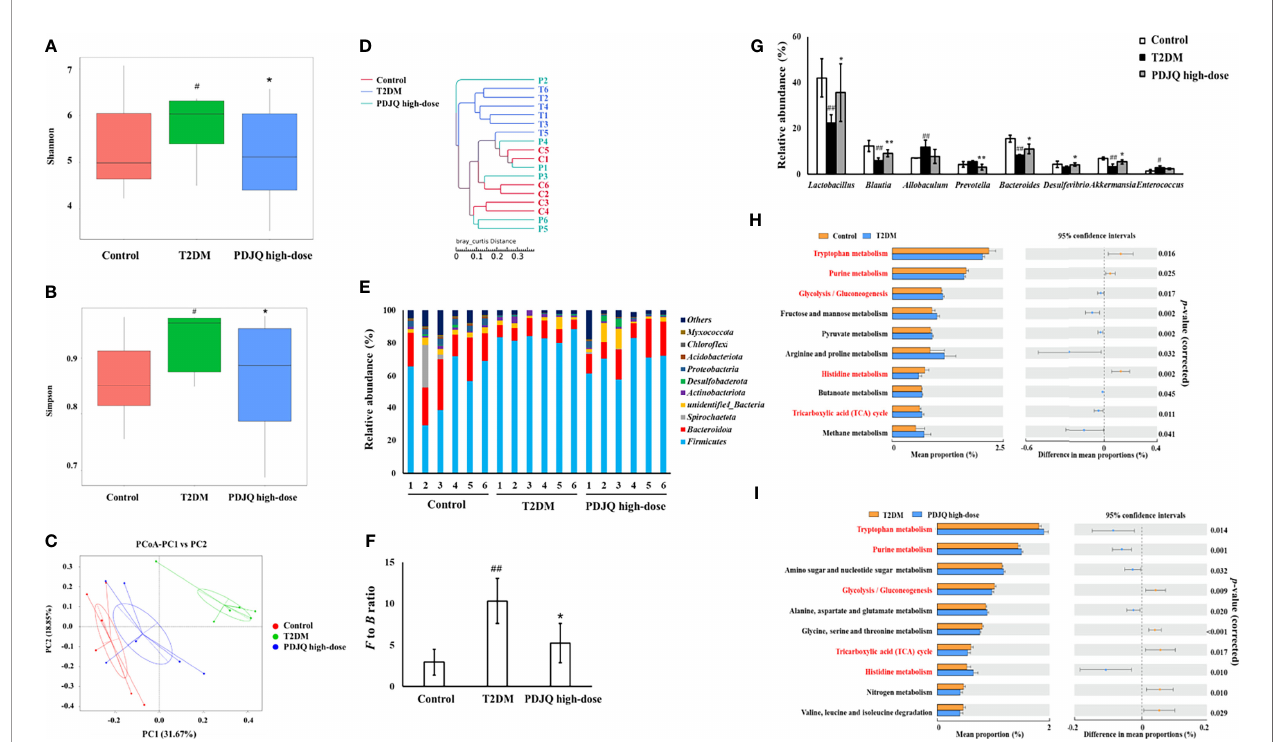
FIGURE 3 | PDJQ treatment affected the gut microbiota community in T2DM rats. (A, B) Shannon and simpson indexes were lower in PDJQ high-dose group than that in the T2DM group. (C, D) PCoA and system clustering tree indicated more similar beta diversity between PDJQ high-dose and Control groups than that between the T2DM and Control groups (C: Control group; M: T2DM group; P: PDJQ high-dose group). (E, F) At the phylum level, PDJQ treatment decreased the F to B ratio in T2DM rats. (G) At the genus level, PDJQ treatment affected the relative abundances of Lactobacillus , Blautia, Prevotella, Bacteroides, Desulfovibrio and Akkermansia in T2DM rats. (H, I) The differential metabolic pathways (written in red) of PDJQ on T2DM were predicted using PICRUSt analysis based on the 16S rRNA sequencing data. Control, T2DM and PDJQ high-dose (n = 6 per group) groups. Data are presented as the mean ± SD. # p < 0.05 as compared to the control group; ## p < 0.01 as compared to the control group; * p < 0.05 as compared to the T2DM group; ** p < 0.01 as compared to the T2DM